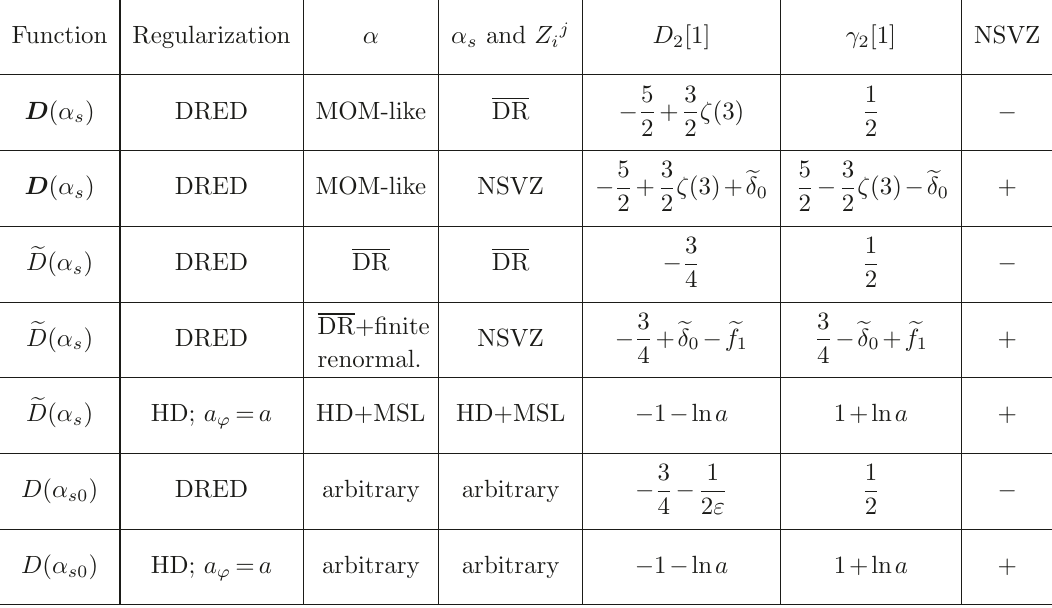
Table 1 . Scheme-dependent coefficients of the β 0 -expansions for different definitions of the D - function and of the anomalous dimension of the matter superfields in various renormalization